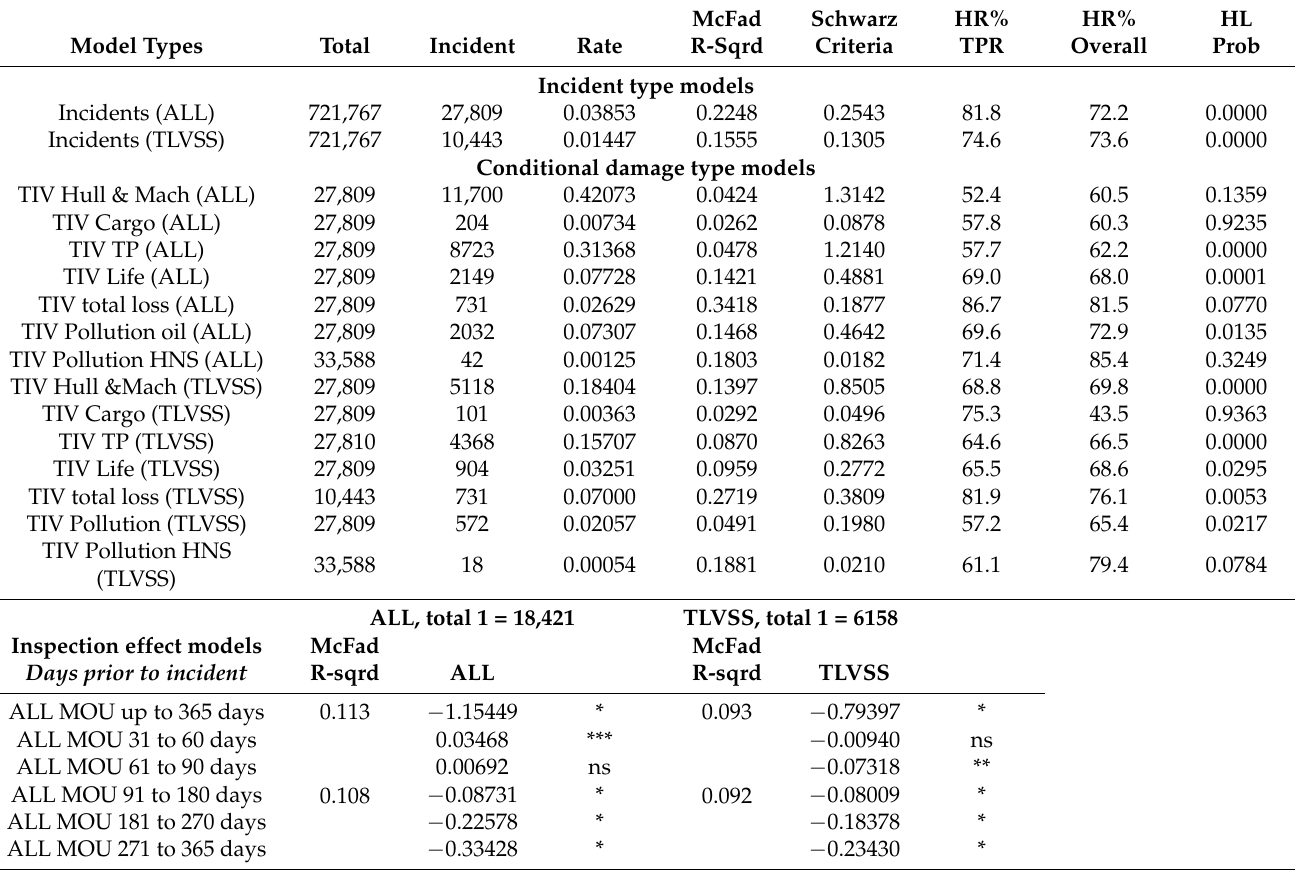
Table A3. Summary statistics of probability and inspection effect models (2014 to 2019) sample